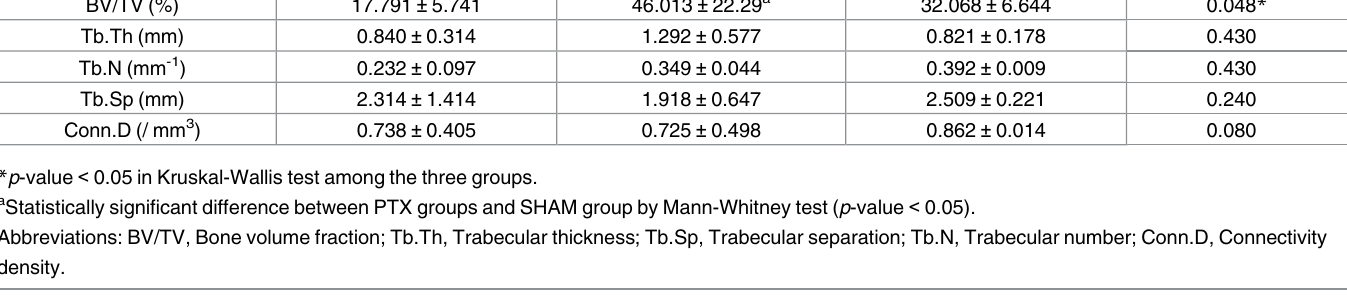
Table 5. Bone histomorphometry in sham-operated and parathyroidectomized groups. Data are expressedas the means ± standard deviation. SHAM